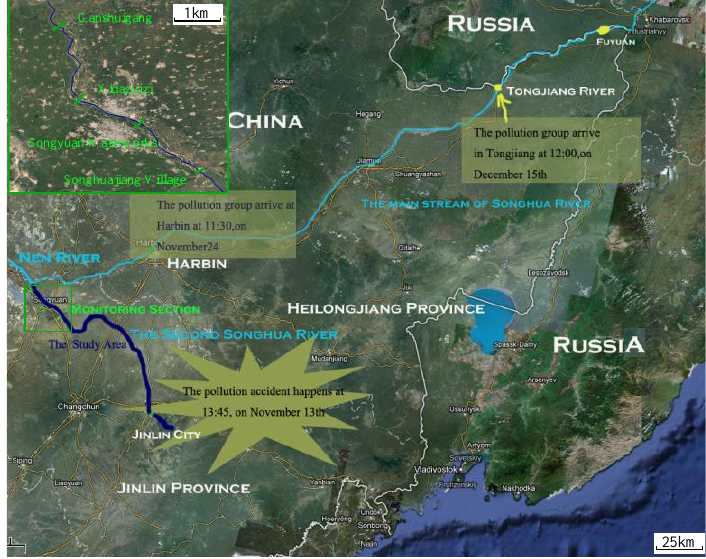
Figure 2. The Songhua River nitrobenzene spill incident occurred in 2005.